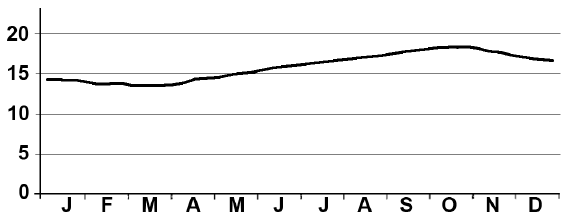
Figure 4. Average seasonal temperature variation (y-axis in Celsius degrees) of sea water in the Gulf of Naples between 10 m and 70 m of depth (modified after [38]).